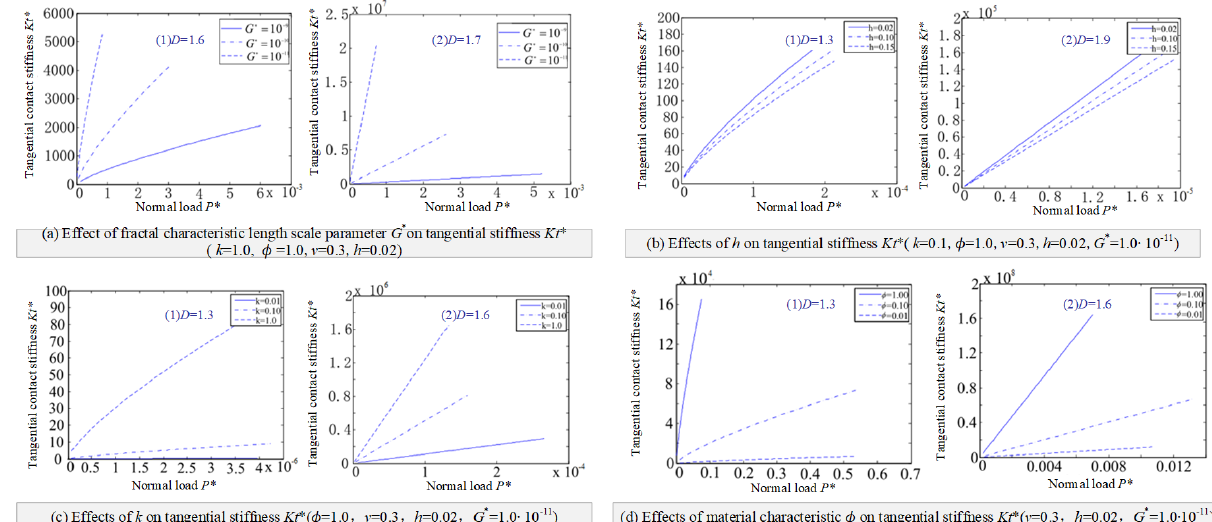
Figure 11. Effects of different characteristic parameters on tangential stiffness K ∗ t .